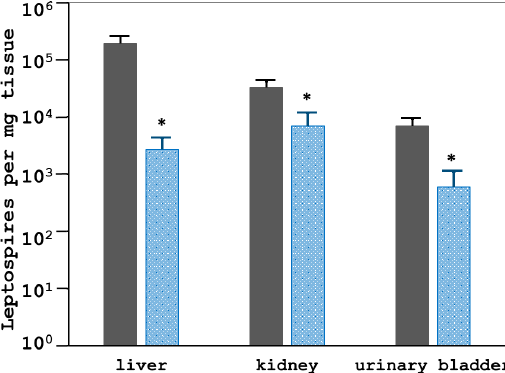
Figure 6. The effect of the 2271 immunization on the leptospiral load in tissues from the control ( n = 8; dark gray bar) and immunized ( n = 8; blue bar) animals after the challenge from experiment 2. The total RNA from each tissue was isolated and reverse-transcribed to cDNA. The cDNA of a specific Leptospira gene, LipL32, was quantified by qRT-PCR. The number of Leptospira in the sample was analyzed by comparing the CT value of the standard curve for each various tissue with the copy numbers in each standard spiked curve. The data represent the log scale of the mean bacterial loads in ± S.E.M. The * indicates the significant differences with a p- value < 0.05. Table 1. The conclusive determination of the presence of Leptospira cultured from the liver, kidney, and urinary bladder from the Control ( n = 8) and immunized ( n = 8) animals after the challenge. The liver, kidney, and urinary bladder from the infected animals were cultured in EMJH medium and maintained at 30 °C for 4 weeks. The growth of leptospires was monitored using dark-field micros- copy. The visible f leptospires in culture samples were counted as positive, and those without visible leptospires were counted as negative. The * indicates the significant differences with a p- value < 0.05. Culture Results (Score)